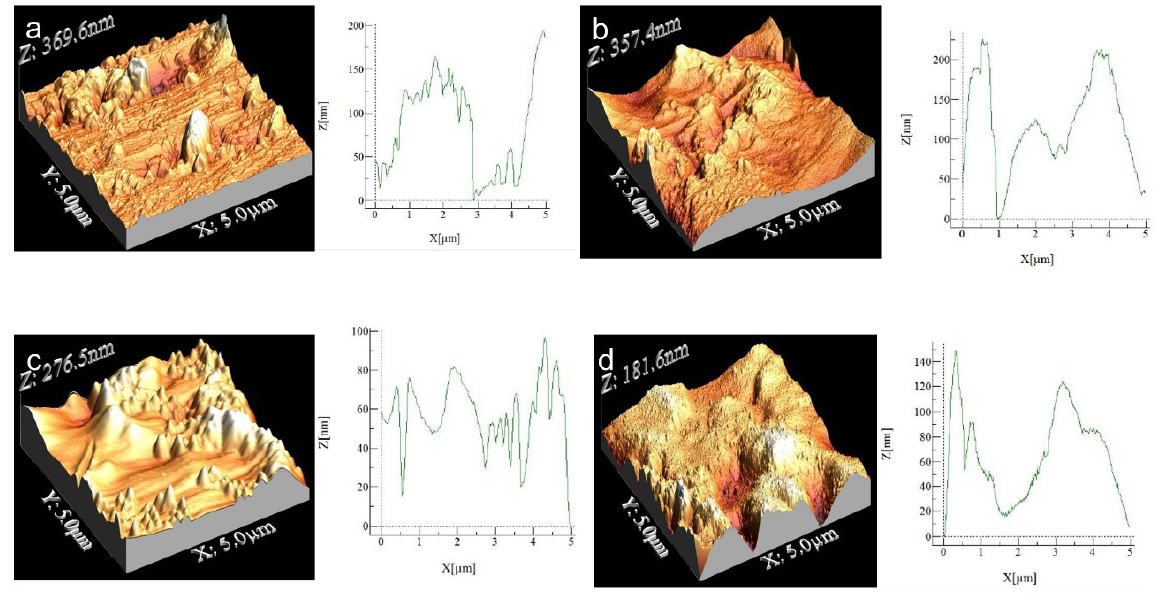
Figure 2: The images of surface topography in Atomic Force Microscope of titanium substrate (a), zirconia/silica coating (b), zirconia/silica coating modified by 0.1 µl/mL resveratrol (c) and by 0.5 µl/mL resveratrol.